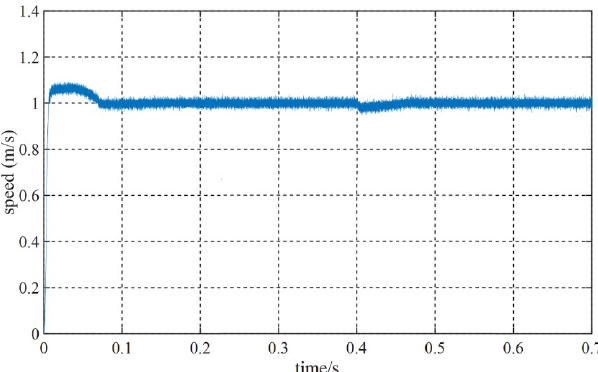
Figure 14. Bar chart of speed overshoot for two controllers.